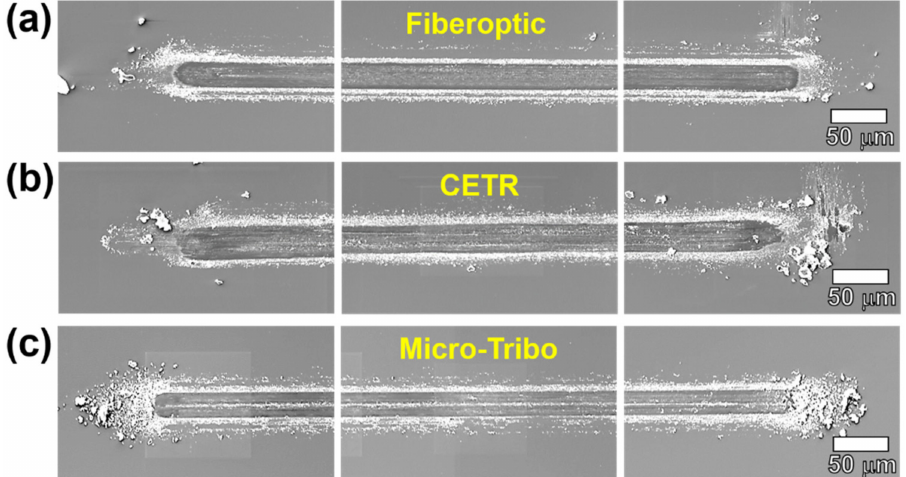
Figure 6. SEM images of the wear tracks on the Si wafer substrate generated by zirconia balls using the ( a ) fiberoptic sensor–cantilever tip-based tribotester, ( b ) commercial (CETR) tribotester, and ( c